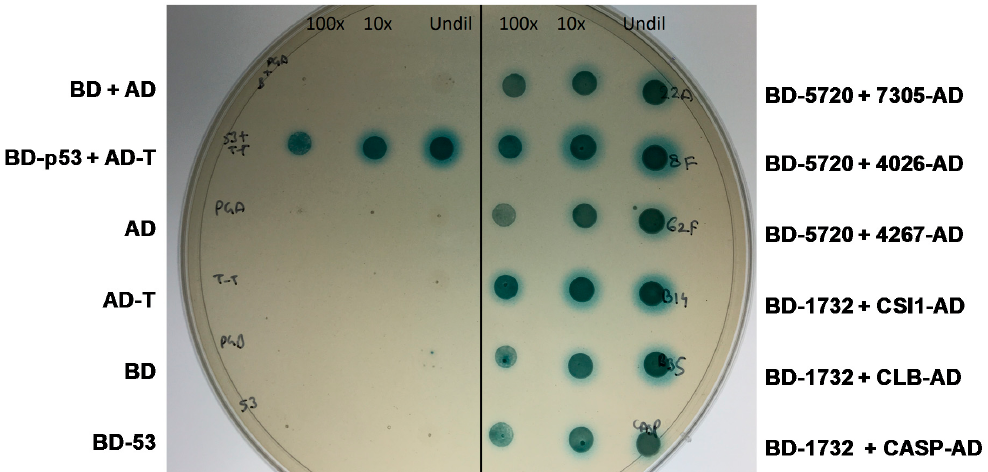
Figure 4. Yeast two-hybrid spot test results for all four proteins and positive and negative controls on quadruple drop-out medium (QDO)/X- α -gal + 3AT (5 mM) plates. For the spot test, each strain bearing the plasmid was grown in 3 ml of appropriate drop out liquid media at 30 °C and shaken at 280 rpm for 2 days. To reconfirm the interaction, 10 Μ L of each culture (washed and resuspended in 0.9% w / v NaCl) was mixed and spotted on QDO plates containing X- α -gal at the indicated dilutions and incubated at 30 °C for 3–5 days. Undil, undiluted; 10× and 100× dilutions.